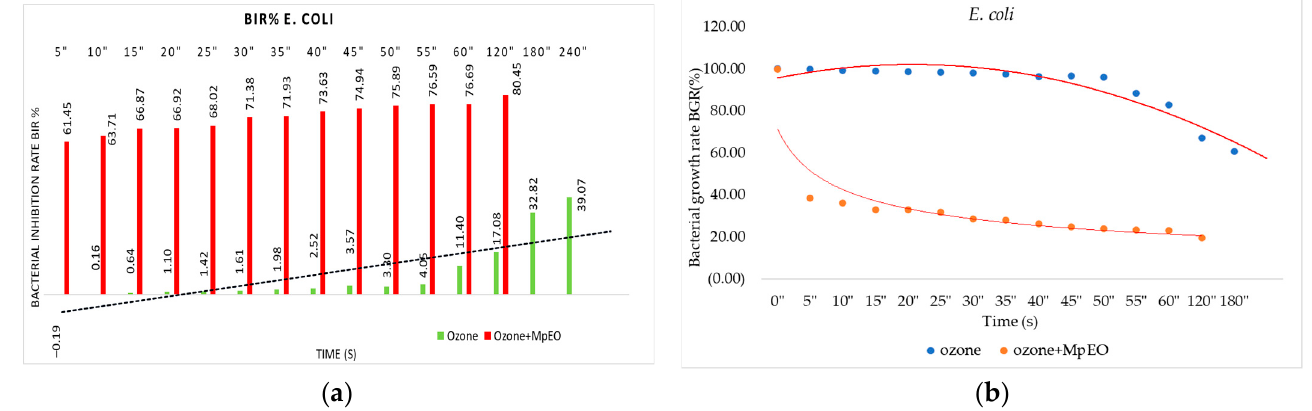
expressed in seconds ( ″ ). ( a ) Results expressed as BIR%; ( b ) results expressed as BGR%.